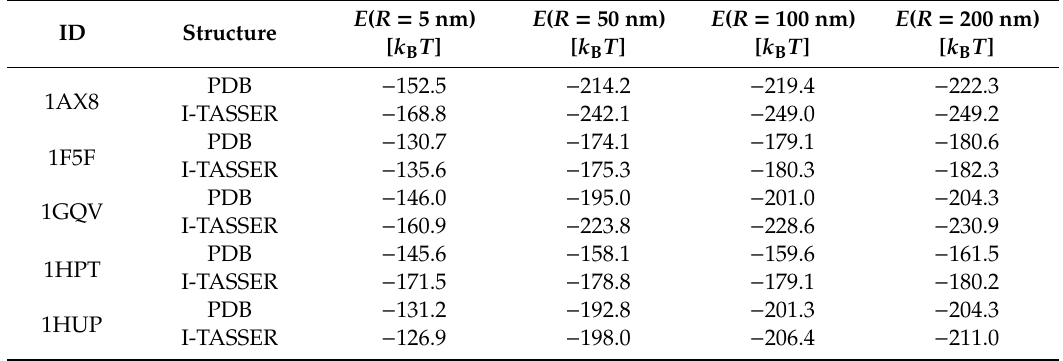
Table 2. Binding-free energy values of five sample proteins for their structures taken from the PDB and calculated using I-TASSER on gold NPs of radius 5, 50, 100, and 200 nm.